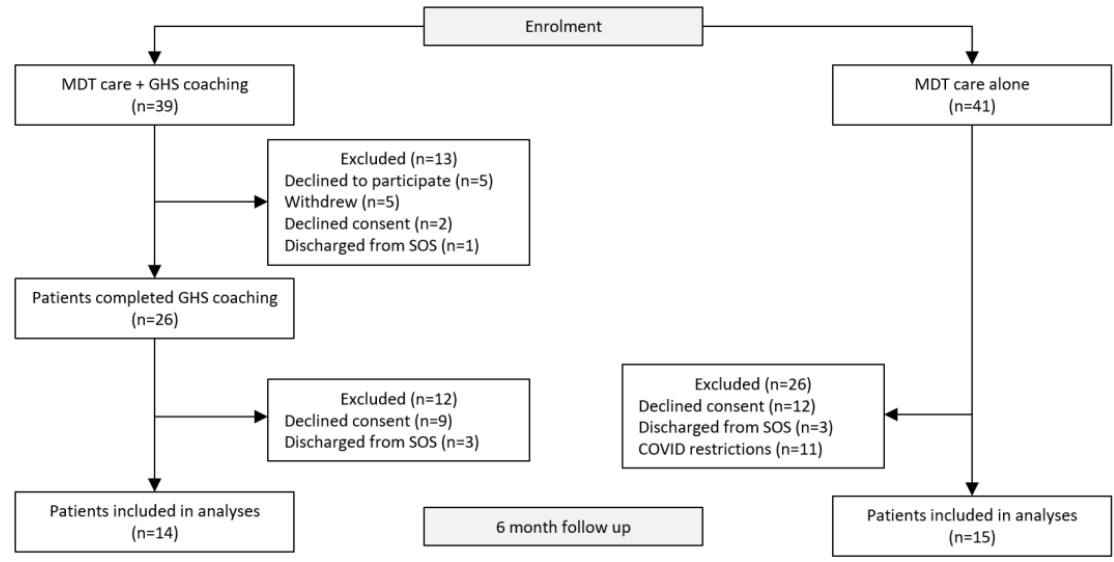
Figure 1. Study design and participation from recruitment to 6 months.